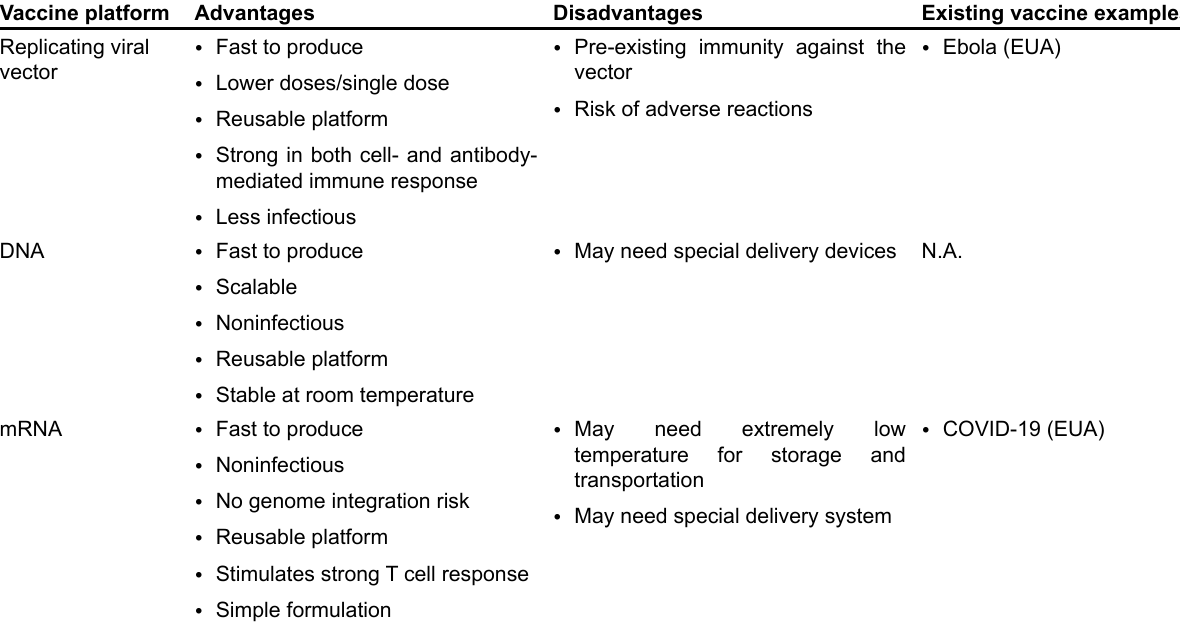
Table 1. Vaccine platforms and their potential advantages and disadvantages [ 22 ] ( continued ) Vaccine platform